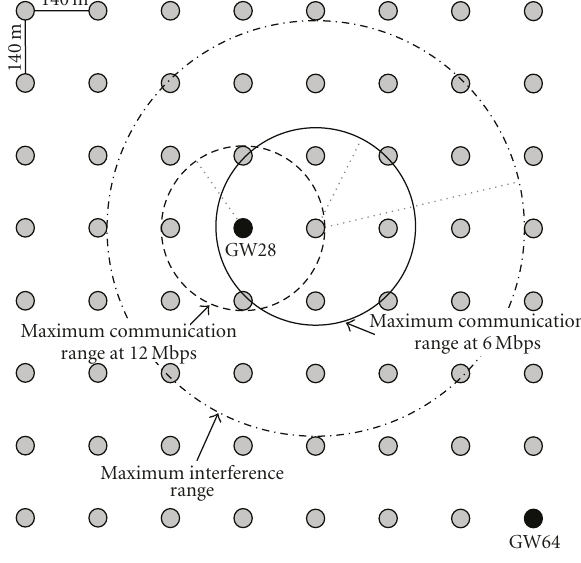
Figure 3: Simulation scenario.